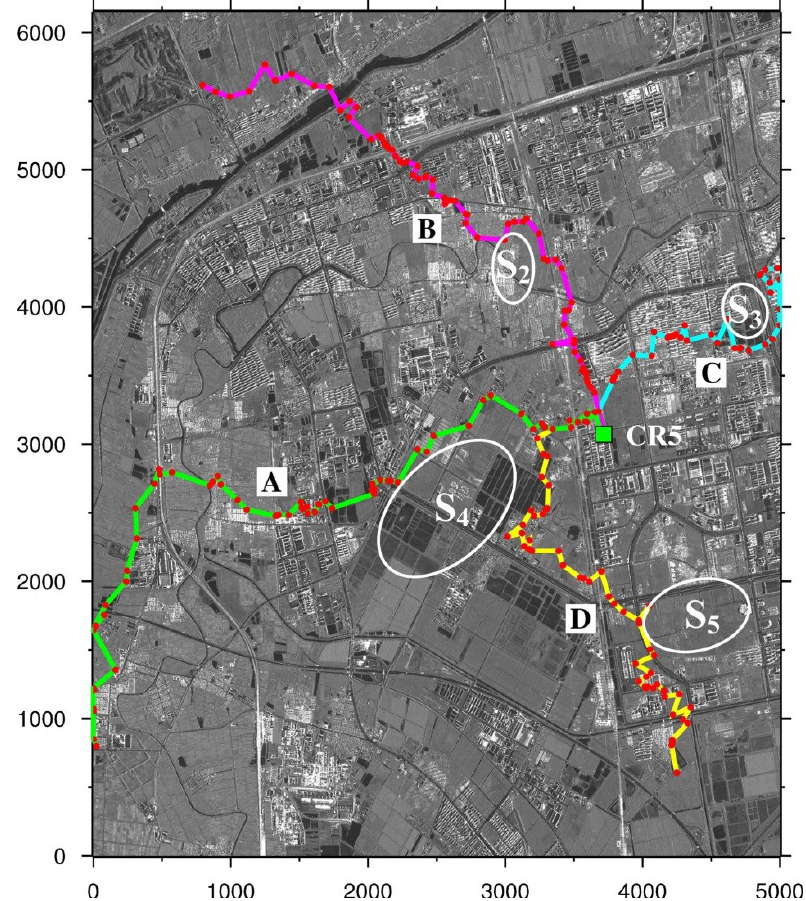
Figure 5. Examples of the optimized integral paths labeled by A, B, C and D for calculating the subsidence rates at four PTs,